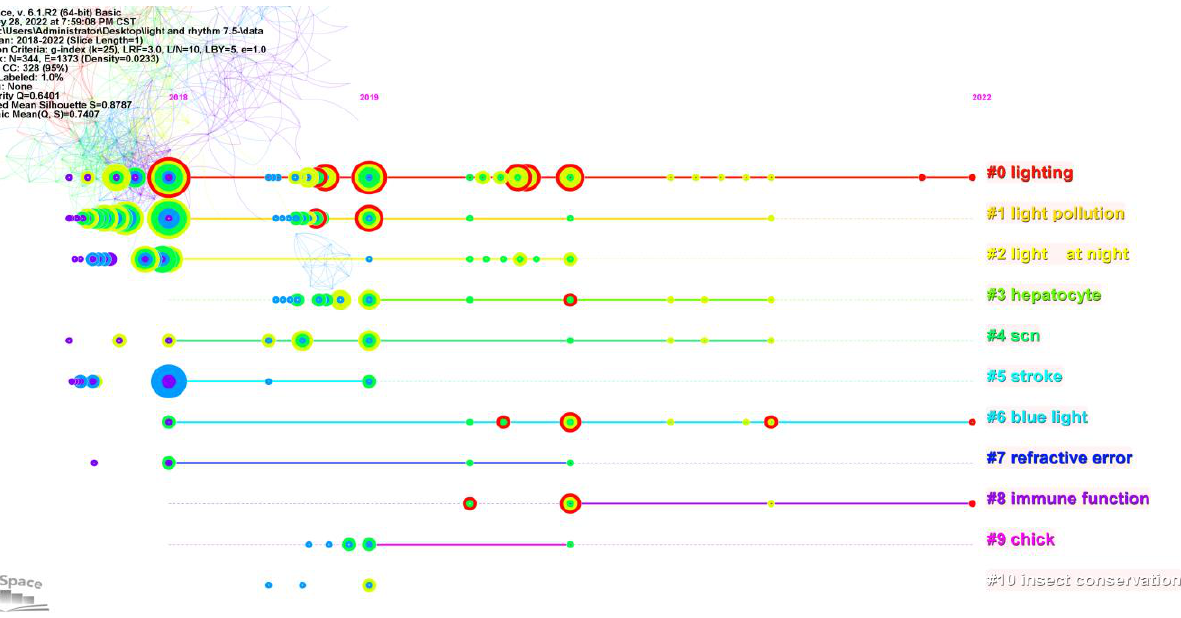
citations of corresponding documents. Purple color outer circle represents high centrality, and red